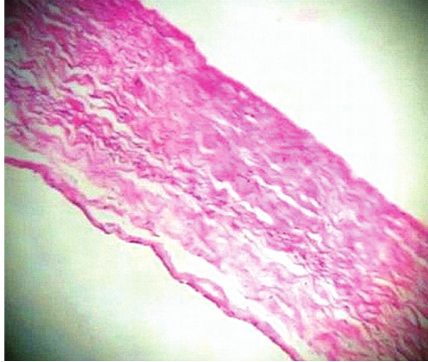
Figure 4: Histology of the cystic part: thin fibrocollagenous cyst wall lined by flattened/cuboidal epithelium. (H&E × 400).